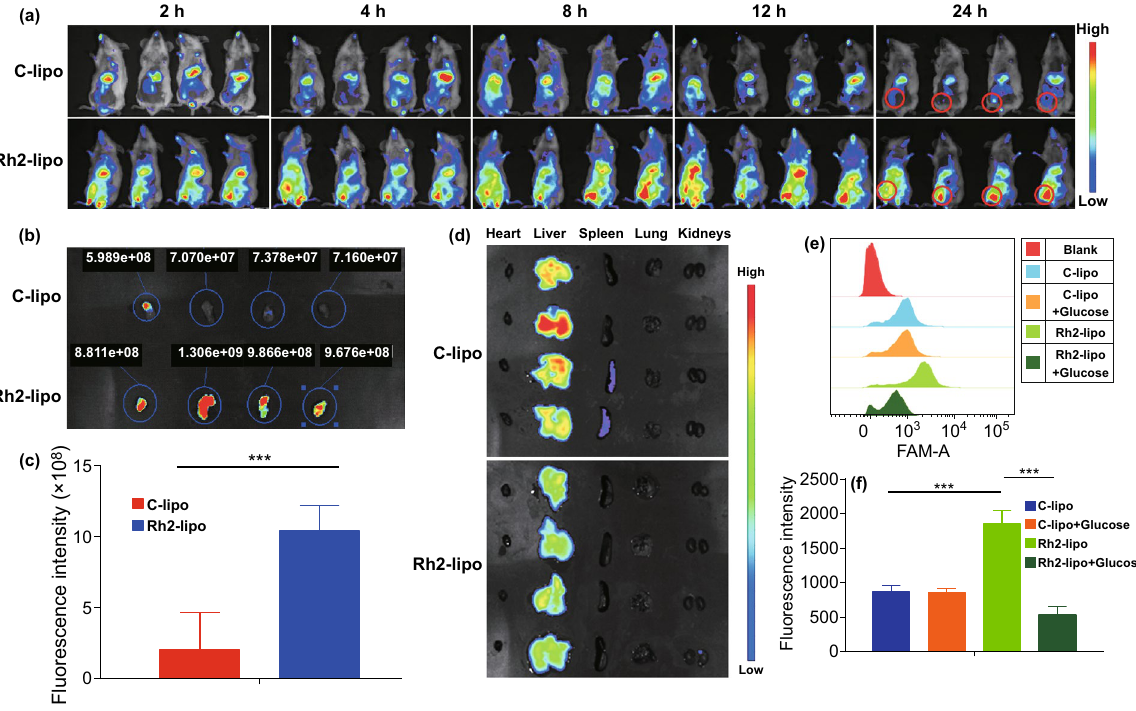
Fig. 4 Rh2 worked as an active targeting ligand, which enhanced liposomes to accumulate in tumor by the interaction with GLUT. a Biodistri- bution of the DID-labeled C-lipo and Rh2-lipo after intravenous injection in 4T1 tumor-bearing mice. b Fluorescence images of excised tumors at 24 h. c Fluorescence intensity in tumors from different groups ( n = 4; mean ± SD). *** P < 0.001. d Fluorescent images of dissected organs of mice sacrificed 24 h. e Cellular uptake of FAM-labeled Rh2-lipo and its competition with glucose using flow cytometry analysis. f Ratio of the relative fluorescence intensity of cellular uptake from different groups ( n = 3; mean ± SD). *** P <